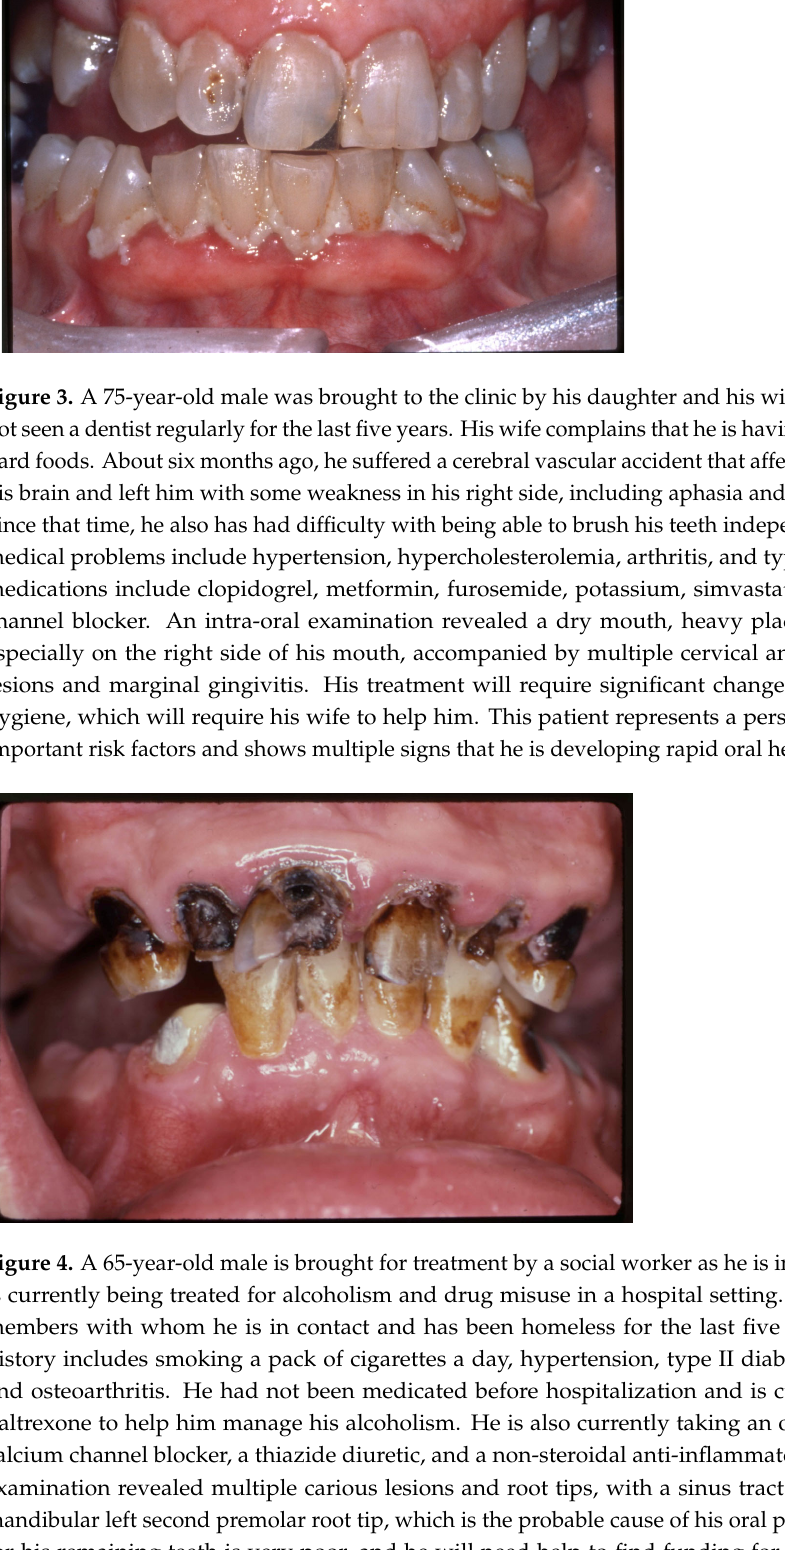
is broken down, it was asymptomatic, has no caries or periapical pathology, and she was not con- cerned with the esthetic correction of this tooth. This patient represents a person who has several important risk factors but does not show any signs of rapid oral health deterioration.